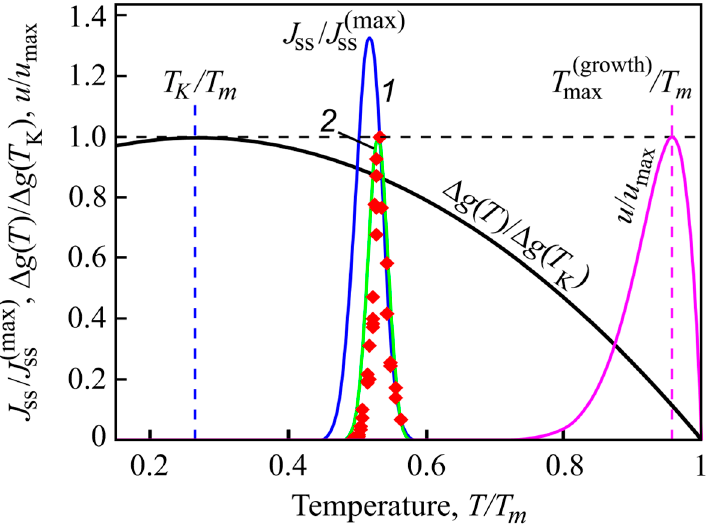
Figure 10. Normalized steady-state nucleation rate, J SS / J and normalized crystal growth rate, u/u max , in dependence on reduced temperature, T/T m . Here, J is the maximum nucleation rate and u max is the maximum growth rate obtained via experiment, T m is the melting or liquidus temperature. The blue curve (1) shows the theoretical result when the kinetic term in the expression for the nucleation rate is determined via appropriate diffusion coefficients, the green curve (2) is drawn under assumption of validity of the Stokes–Einstein–Eyring equation allowing one to replace the diffusion coefficient by viscosity. Its wide coincidence with experimental data is reached by employing appropriate expressions for the curvature dependence of the surface tension. The reduced thermodynamic driving force, ∆ g ( T ) / ∆ g ( T K ), is shown as well, it has a maximum at the Kauzmann temperature, T K . It is evident that crystallization occurs only in a relatively small temperature range. Typically, the maximum of the growth rate, T max , is located at temperatures much higher than the maximum of the steady-state nucleation nucleation rate. Reproduced from [35], Figure 1 therein,